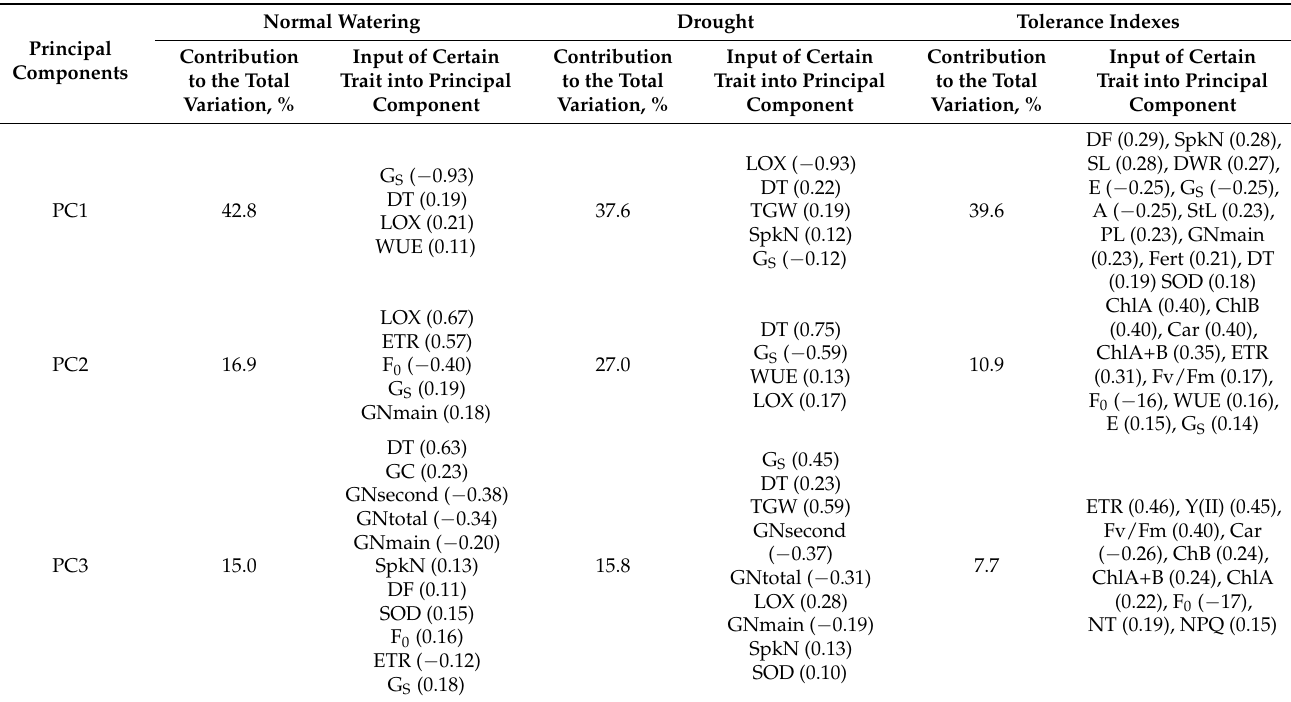
Table 1. Principal component analysis under two water